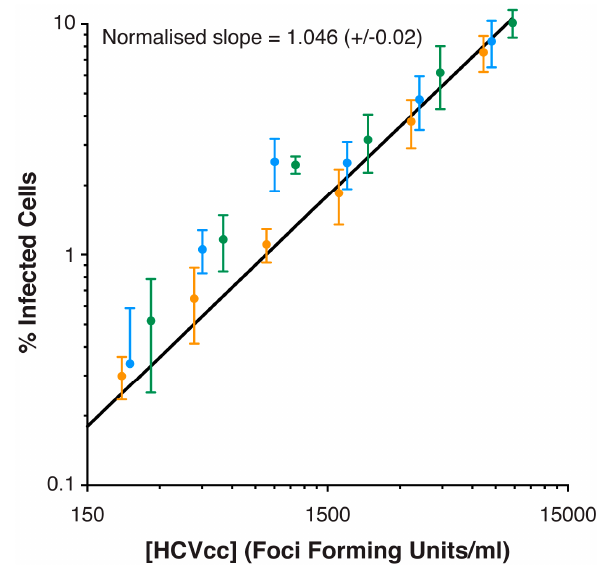
Figure 3. Serial dilution of HCVcc. Three independent stocks of J6/JFH HCVcc (green, blue and orange markers) were serially diluted from 1/400 to 1/102400 and inoculated on to Huh-7.5 cells in replicates of six. The cells were fixed at 48 h, stained for viral antigen and nuclear DNA, and imaged using a plate-reading fluorescence microscope. The titer of each stock was calculated using the standard FFA (as described in materials and methods) and the proportion of infected cells at each concentration was estimated using Infection Counter. The plot displays concentration of HCVcc (extrapolated from the viral titer) versus the estimated percentage of infected cells. Linear regression was performed and produced a line of best of fit which, when normalized for differences in units, exhibited a slope of 1.046, indicating a near-perfect linear relationship between the concentration of HCVcc and estimated proportion of infected cells. Error bars indicate standard deviation from the mean, n =